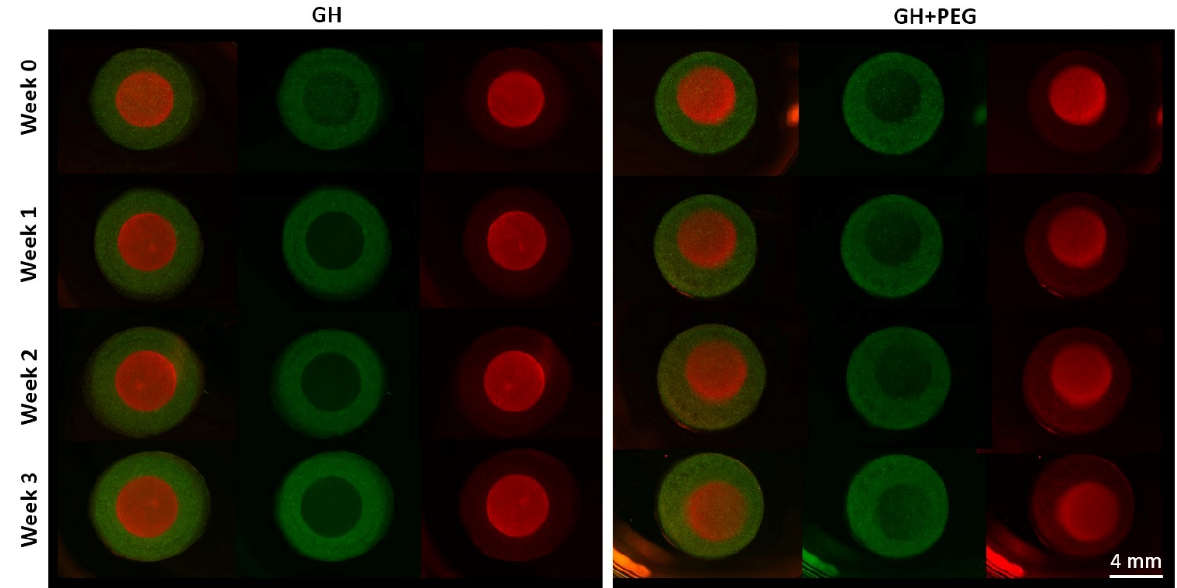
Figure 6. Cell migration test. Cells in the ring and disc insert were labeled with DiO (green) and DiI (red) separately.